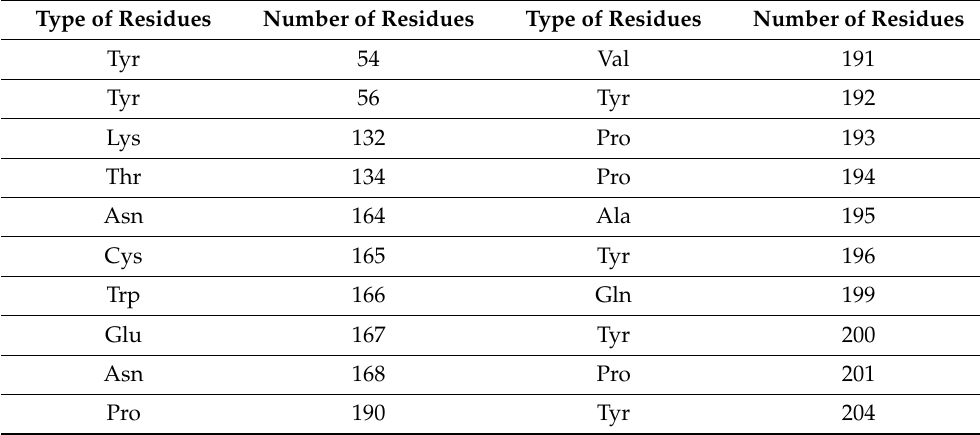
Table 2. The residues that have a close relationship with catalytic cavity using Molegro Virtual Docker software.